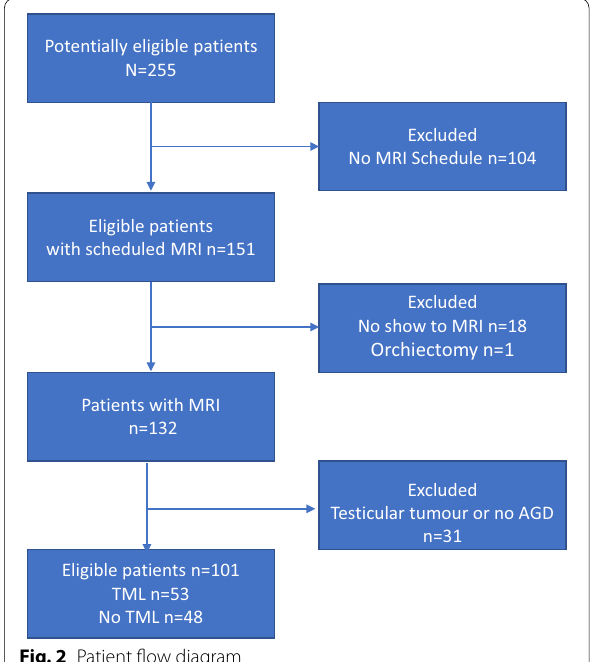
Fig. 2 Patient flow diagram